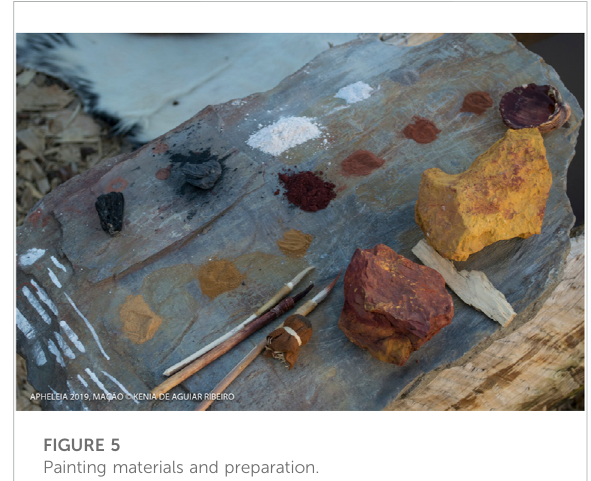
FIGURE 5 Painting materials and